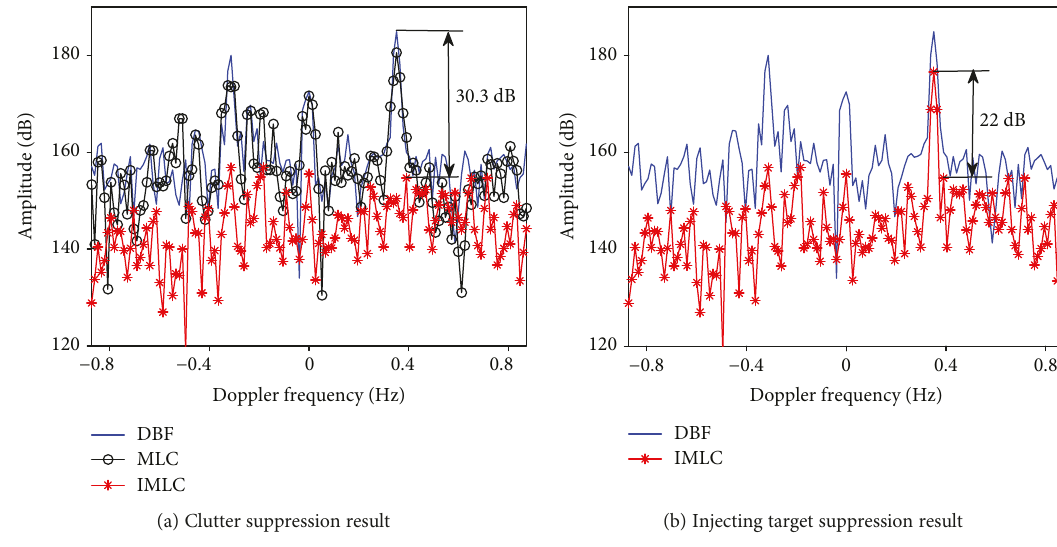
Figure 18: Suppression results for clutter and clutter plus target.